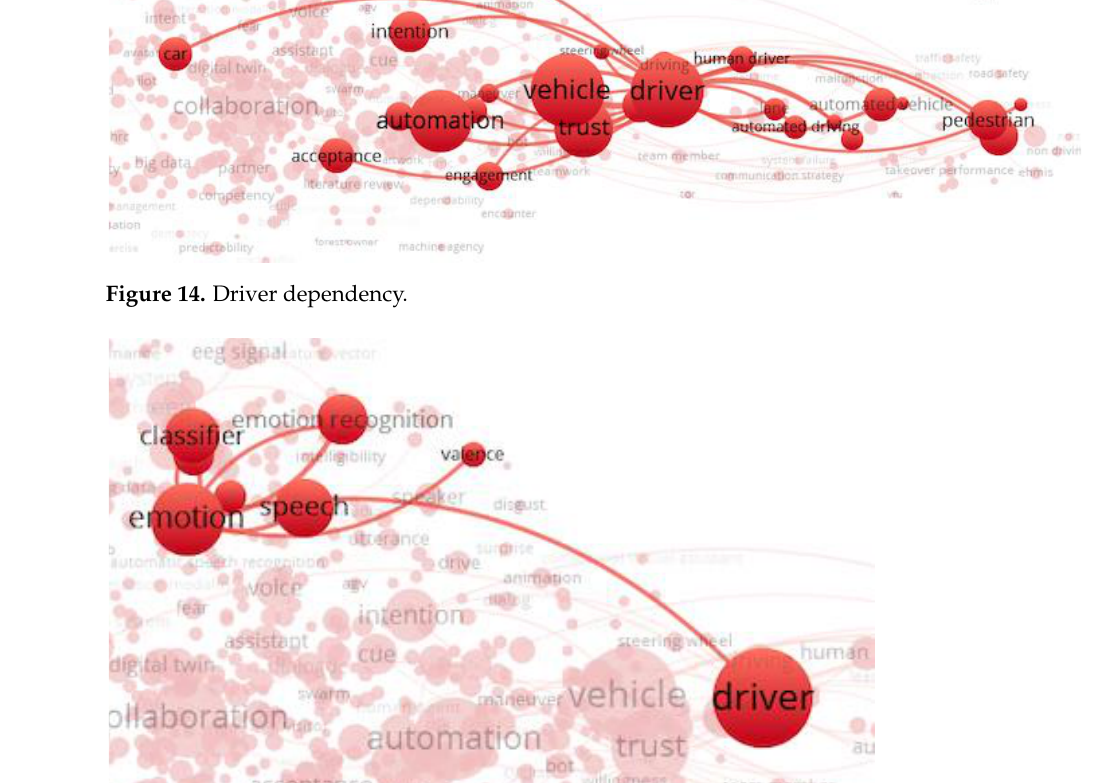
Figure 15. Emotion dependency.